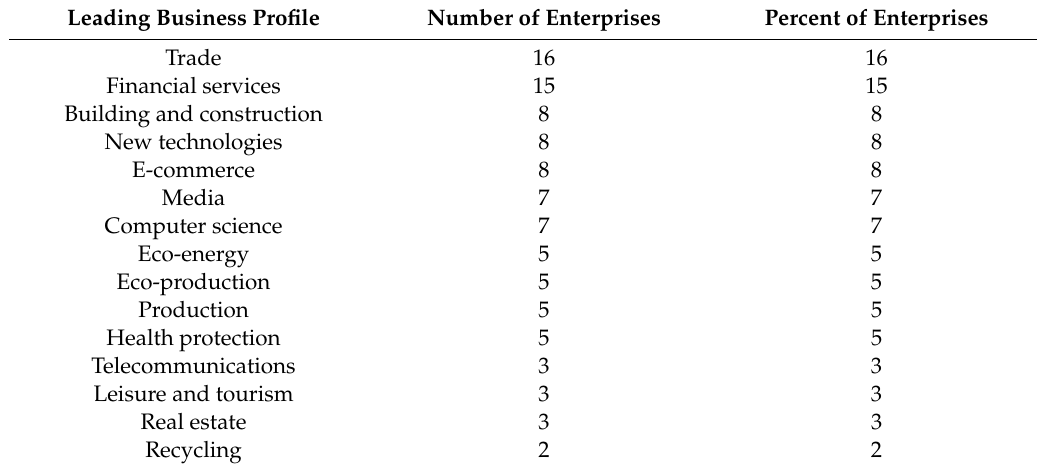
Table 5. Leading business profiles of enterprises (N =